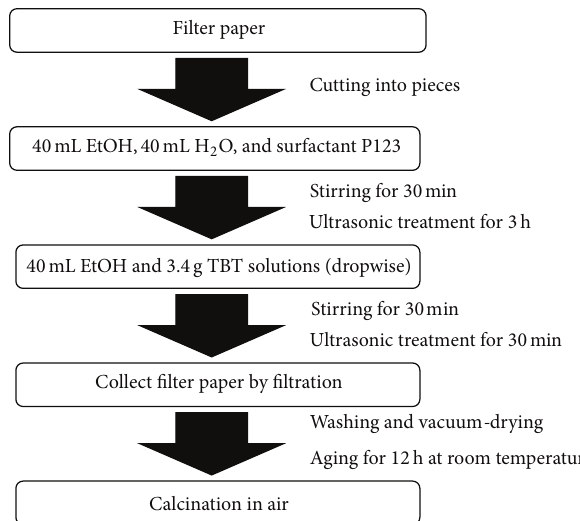
Scheme 1: Schematic illustration of the preparation process for hierarchical titania nanotubes templated by filter